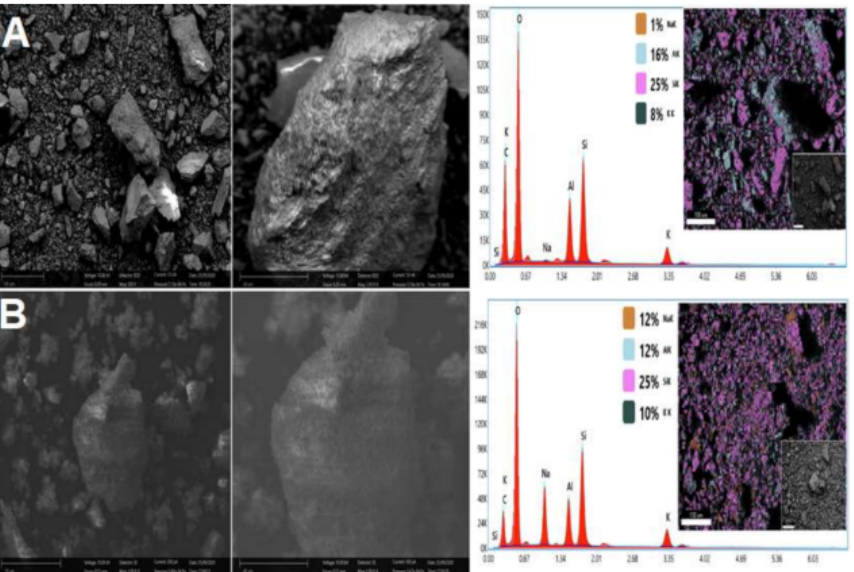
Figure 6. SEM-EDS of the raw material indicating the elemental distribution: ( A ) TS01 and ( B ) TS01H observed at 100 µ m and 40 µ m. (K: potassium, Si: Silicium, Na: Sodium, Mg: Magnesium, Al: Aluminium, C: Carbon and O: Oxygen).